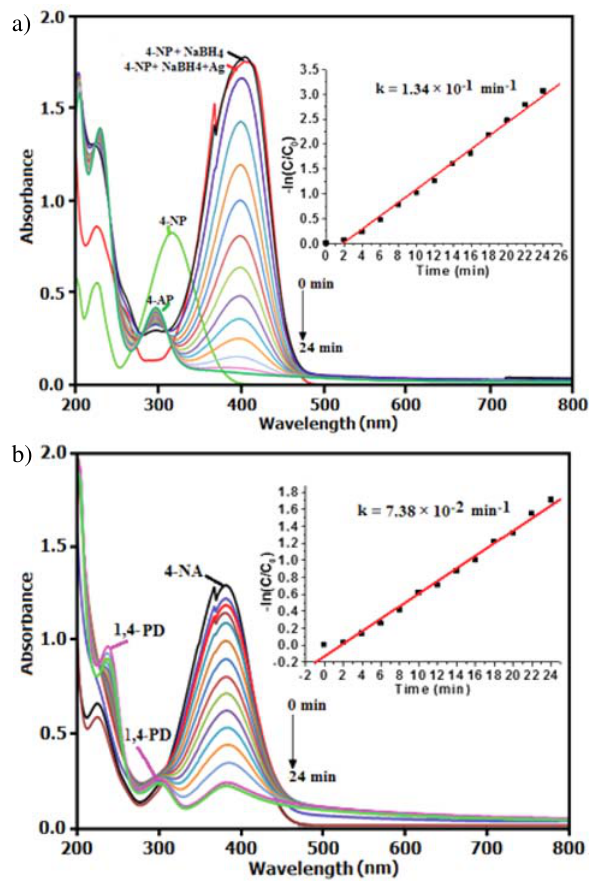
Figure 12 . UV–Vis spectra of (a) 0.1 mM 4-nitrophenol (4-NP) with 10 mM NaBH4 and (b) 0.1 mM 4-nitroaniline (4-NA) with 10 mM NaBH4 in the presence of Ag NPs as catalyst. The insets show the plots of ln(C /C ) against the reaction time for pseudo-first-or- t 0 der reduction kinetics of 4-NP and 4-NA in the presence of excess NaBH (10 mM) in aqueous solutions. 4